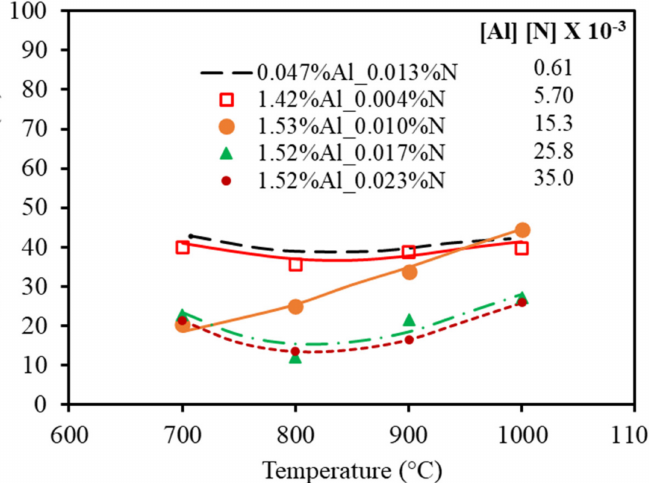
Figure 13. Hot ductility curves for TWIP steels having different products of [Al][N], from 0.61 to 35 × 10 − 3 . Al additions varied from 0.047 to 1.5% and N from 0.004 to 0.0023%. The base composition